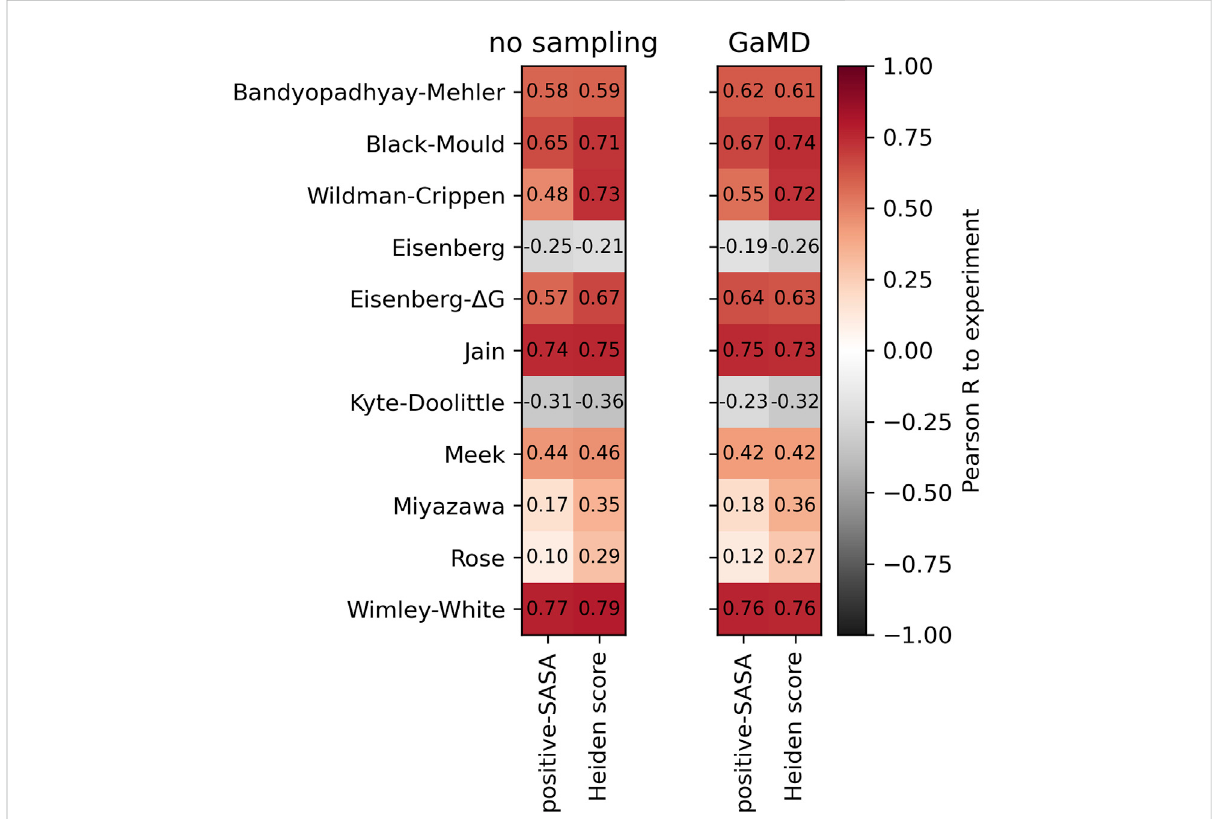
FIGURE 5 Comparison of the performance of the positive-SASA score using the MoFvAb models directly (left panel) and using an average over 200 ns of GaMD simulation (right panel). In each panel, the left column shows the positive-SASA score, while the right column shows the Heiden score. The Pearson correlation was calculated with respect to the HIC retention times of the Roche-127